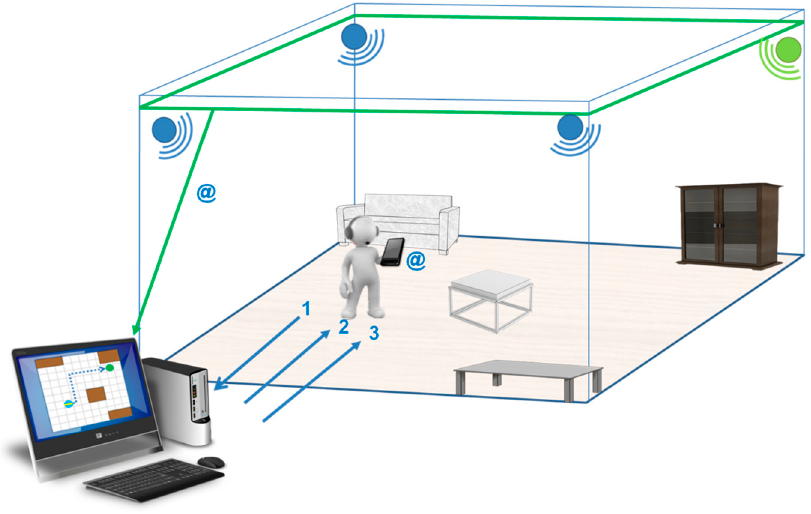
Figure 1. Overall description of SUGAR.